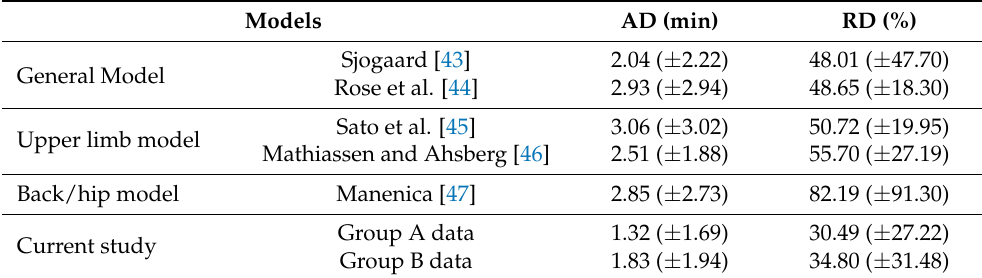
Table 3. AD and RD values of the predictive models.